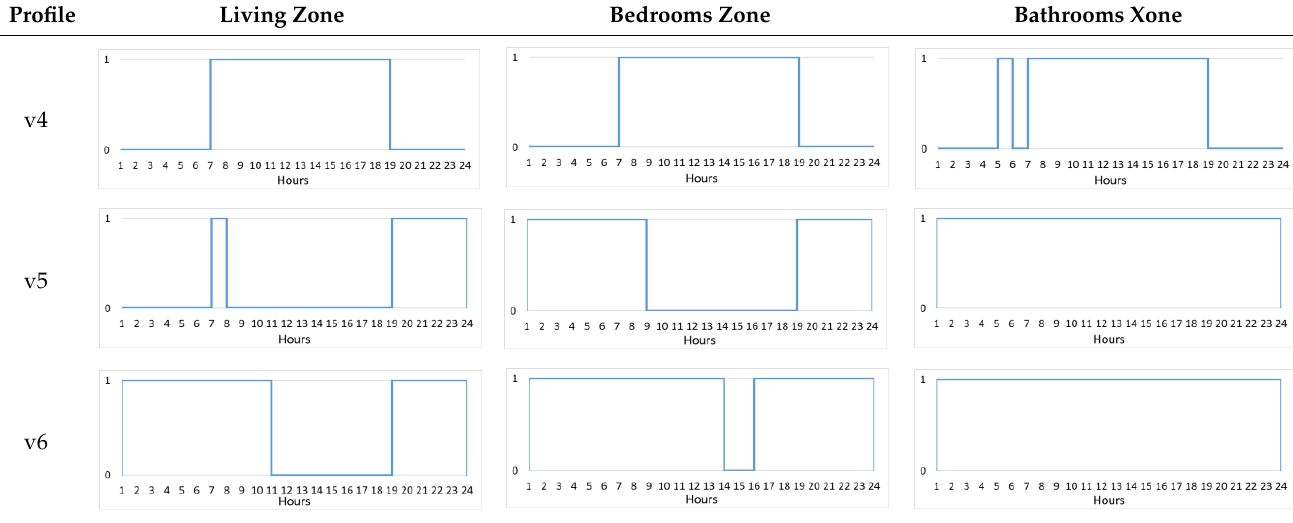
Table 5. Daily natural ventilation schedules in summer (Open = 1, Close = 0). Adapted from [33].